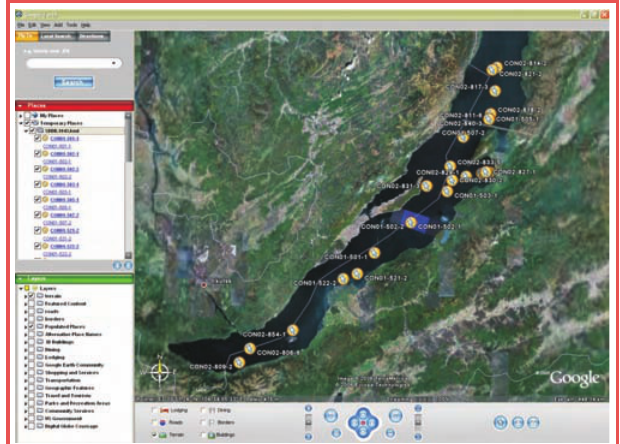
Figure 2. Sampling locations of doi:10.1594/GFZ.SDDB.1043 by Heim et al., 2005. displayed in the Google Earth virtual globe. The place marks at the sampling locations link back to an online description of the field activities at the respective locations as recorded in